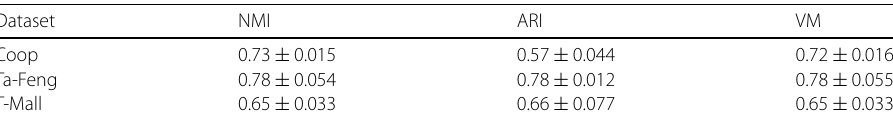
Table 1 Collective clustering cross-validation with respect to Normalized Mutual Information score, Adjusted Rand Index score and V-Measure score. For each measure is reported the mean and the standard deviation among five